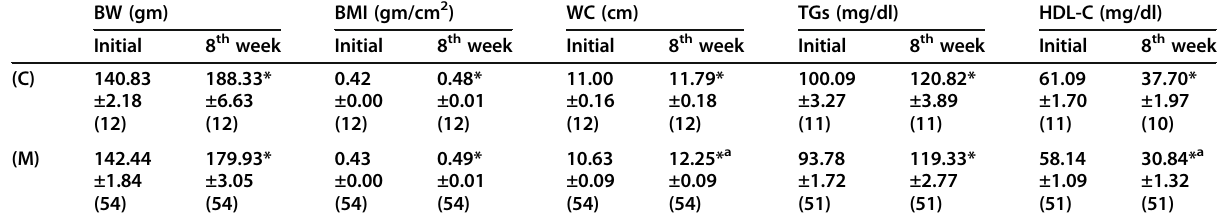
Table 1 The initial and 8 th week anthropometric and lipid parameters in control and metabolic syndrome groups